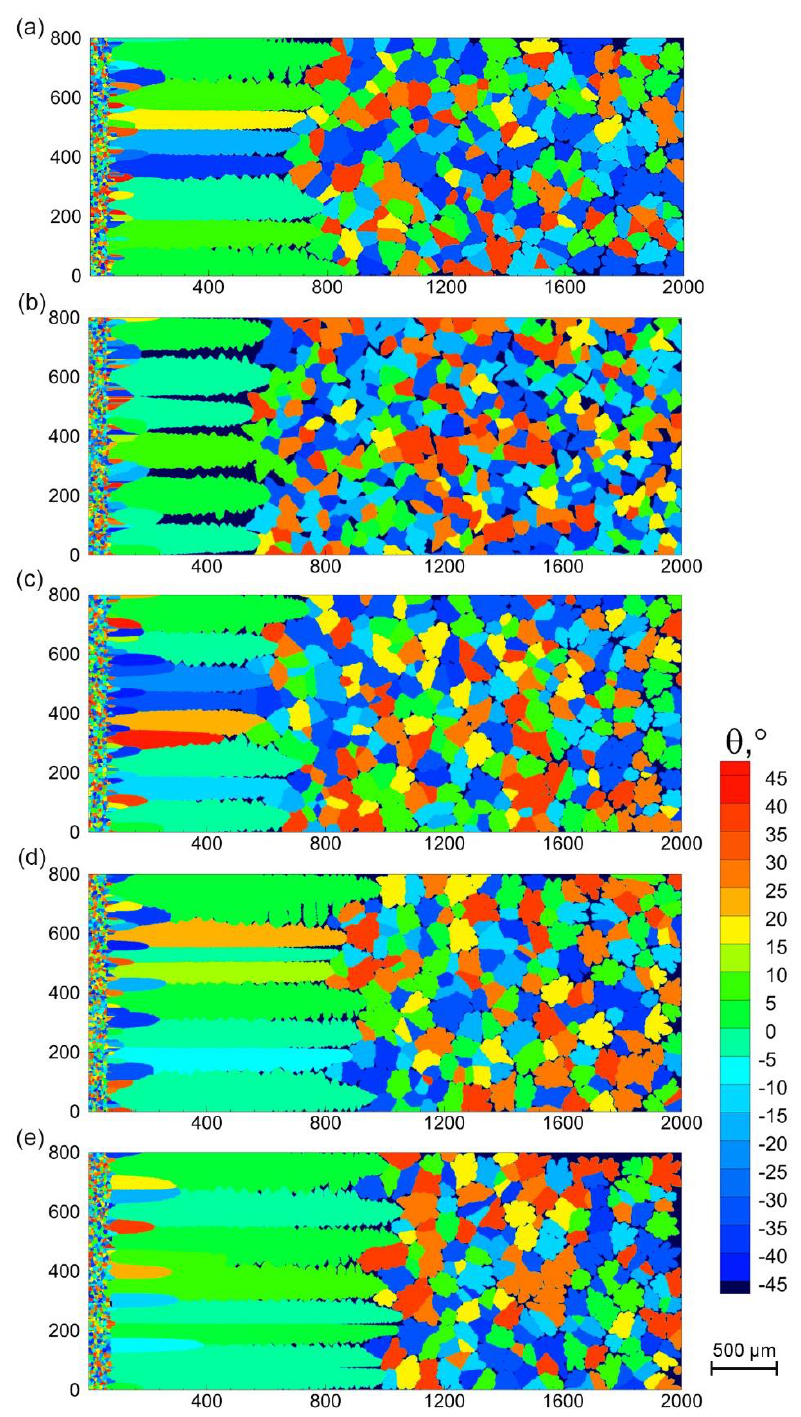
Figure 6. Simulated dendritic structures formed in the melt under different degrees of undercooling on the surface of the crystal nucleus generator. The degrees of undercooling are 200, 300, 400, 500, 700 K from ( a – e ), respectively. Different colors represent grains with different crystallographic orientations.